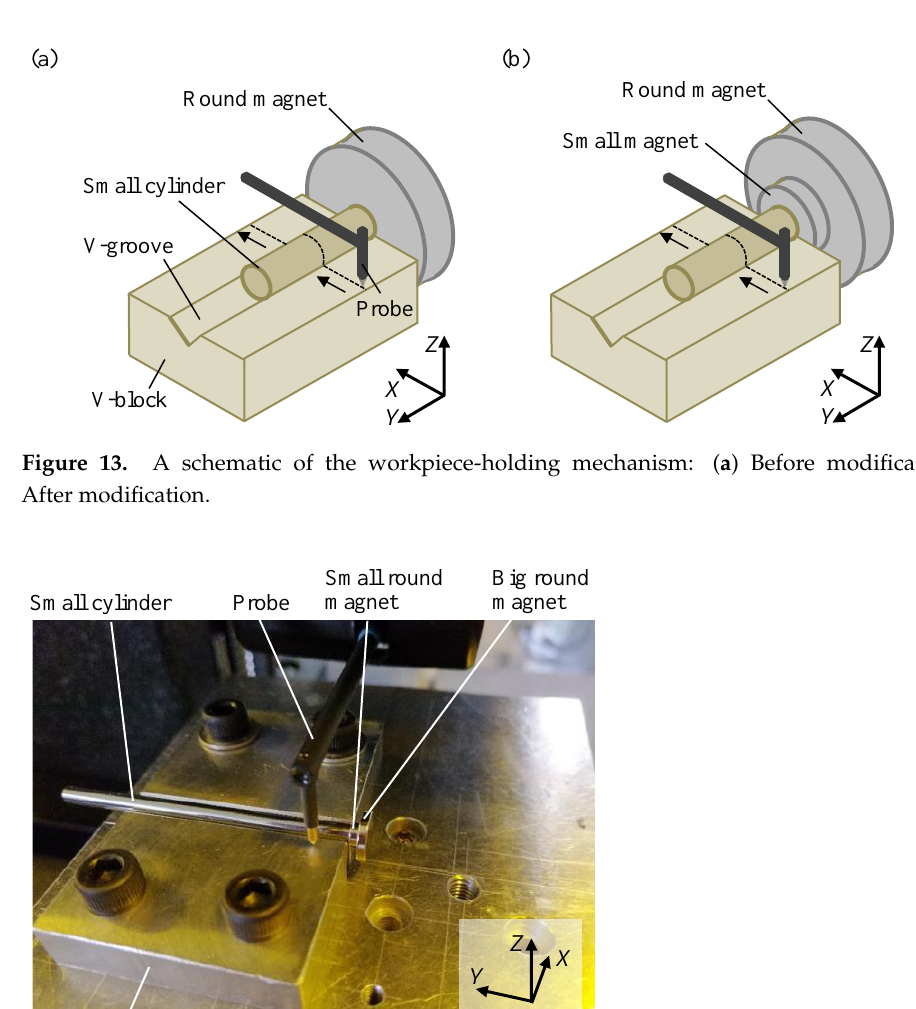
Figure 14. A photograph of the modified setup.